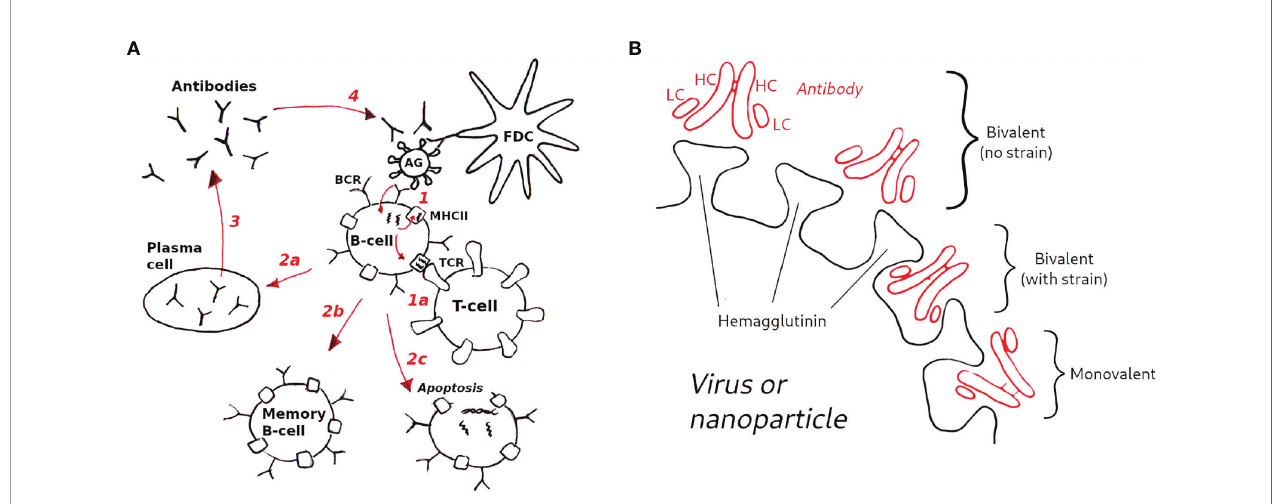
FIGURE 2 | Schematic of the GC model used in this study. (A) Model overview (1): B-cells are activated upon binding to antigen presented on follicular dendritic cells (FDCs, not explicitly modeled); (1a) in the optional T-cell help model (see text) B-cells are activated when the major histocompatibility complex receptor (MHCII) binds to the T-cell receptor (TCR); B-cell activation rescues B-cells from apoptosis, allowing them to mutate and proliferate (2); depending on the activation signal, B- cells can differentiate to plasma cells (2a), to memory B-cells (2b), or undergo apoptosis (2c) (3); Plasma cells secrete antibodies (Abs), which also compete with B- cell receptors for antigen (4), which is the essential aspect of the Ab feedback model (31) (see text). (B) Hypothetical modes of antibody binding to in fl uenza spikes; bivalent binding without strain (top) corresponds to cooperative binding by antibody arms; bivalent binding with strain (middle) corresponds to noncooperative binding; monovalent binding (bottom) is assumed to be the dominant mode of binding of anti-HA stem antibodies (see Methods for